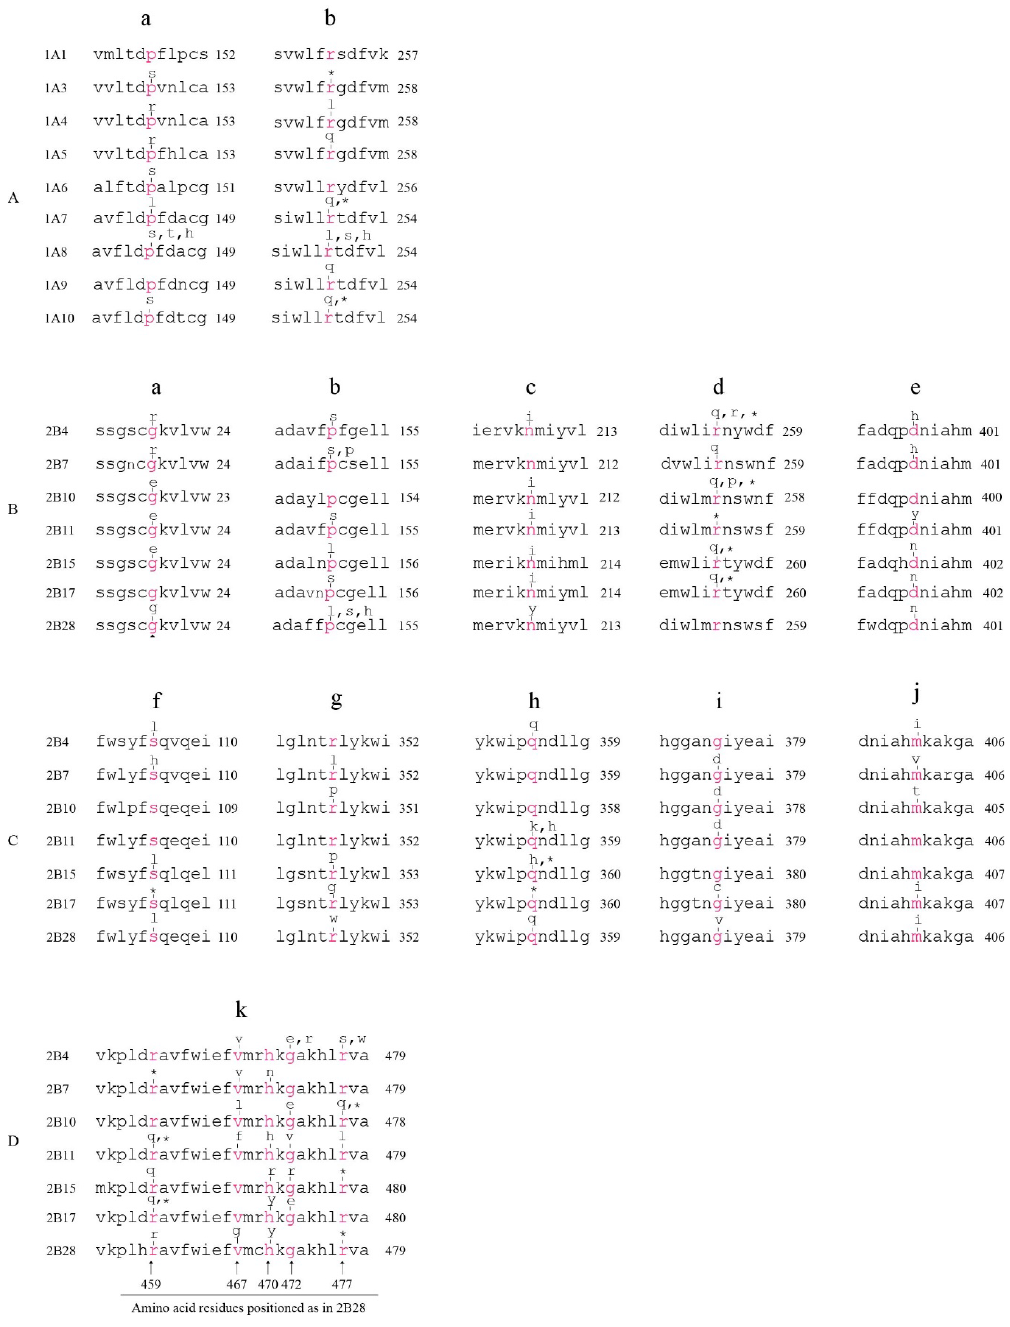
Figure 3. Mutations within the codons of conserved amino acids of the UGT1A and UGT2B family of enzymes. The amino acid sequences of the UGT1A enzymes ( A ) and UGT2B enzymes ( B – D ) are aligned by the Clustal Omega program. Data shown are the sequence alignments surrounding the conserved amino acids [in Red, positions given at the left for ( A – C ) or at the bottom for ( D )] whose codons were mutated in TCGA tumors. (A) Mutations in the codons of UGT1A conserved amino acids (a-b). (B, C, D) Mutations in the codons of UGT2B conserved amino acids (a-k). As indicated above, for the conserved amino acids, these mutations lead to (1) amnio acid substitution (missense), (2) no change in amnio acid sequence (silent mutation) or (3) premature stop codons (nonstop mu- tation, specified by *).